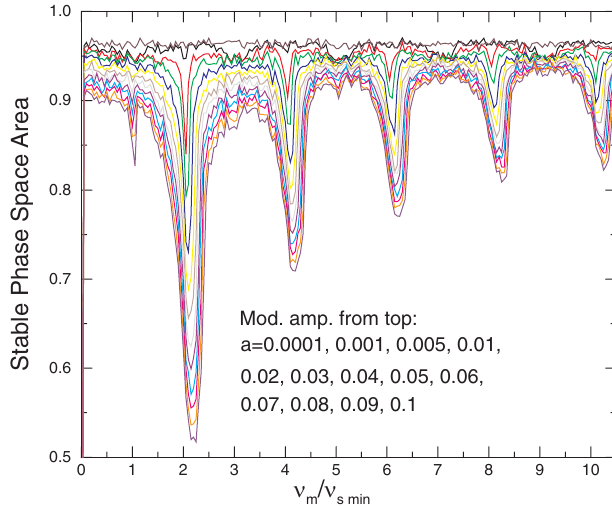
FIG. 6. (Color) Fractional stable bunch area in ratio to the bucket area as functions of voltage modulation tune, for frac- tional modulation amplitudes, from top to bottom, a (cid:1) 0 : 001 , 0.005, 0.01, 0.02, 0.03, 0.04, 0.05, 0.06, 0.07, 0.08, 0.09, 0.1. slightly Large unstable areas are seen when modulation tune (cid:4) m with n (cid:1) 2 ; 4 ; 6 ; 8 ; (cid:12) (cid:12) (cid:12) , a reflection of the larger than n(cid:4) s; min resonances excited. Among them, the 2:1 resonance ( n (cid:1) 2 ) is the most